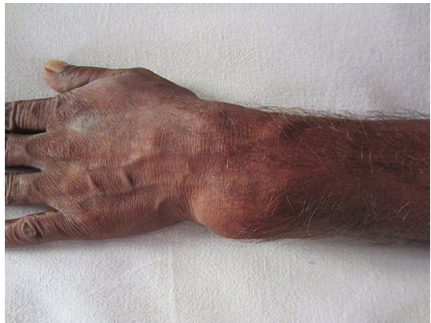
Figure 1: Preoperative clinical photograph.